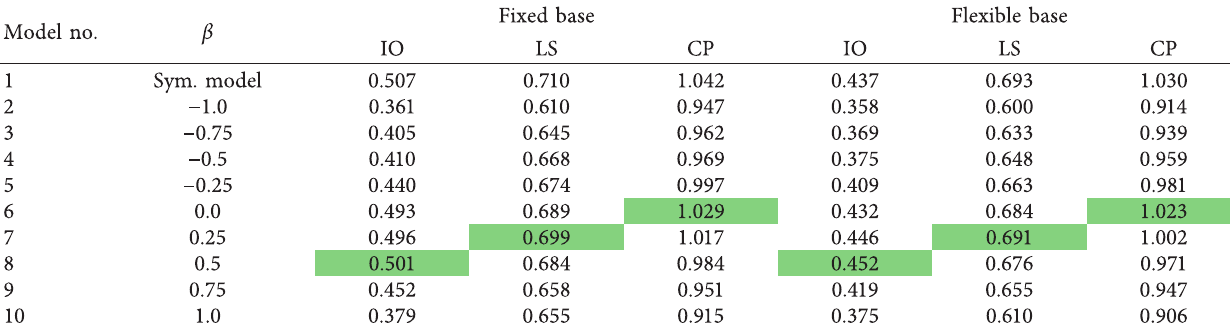
Figure 18: Confidence levels for models with flexible base: (a) IO, (b) LS, and (c) CP. Table 13: IM capacities corresponding to CL � 70% in the models with fixed and flexible